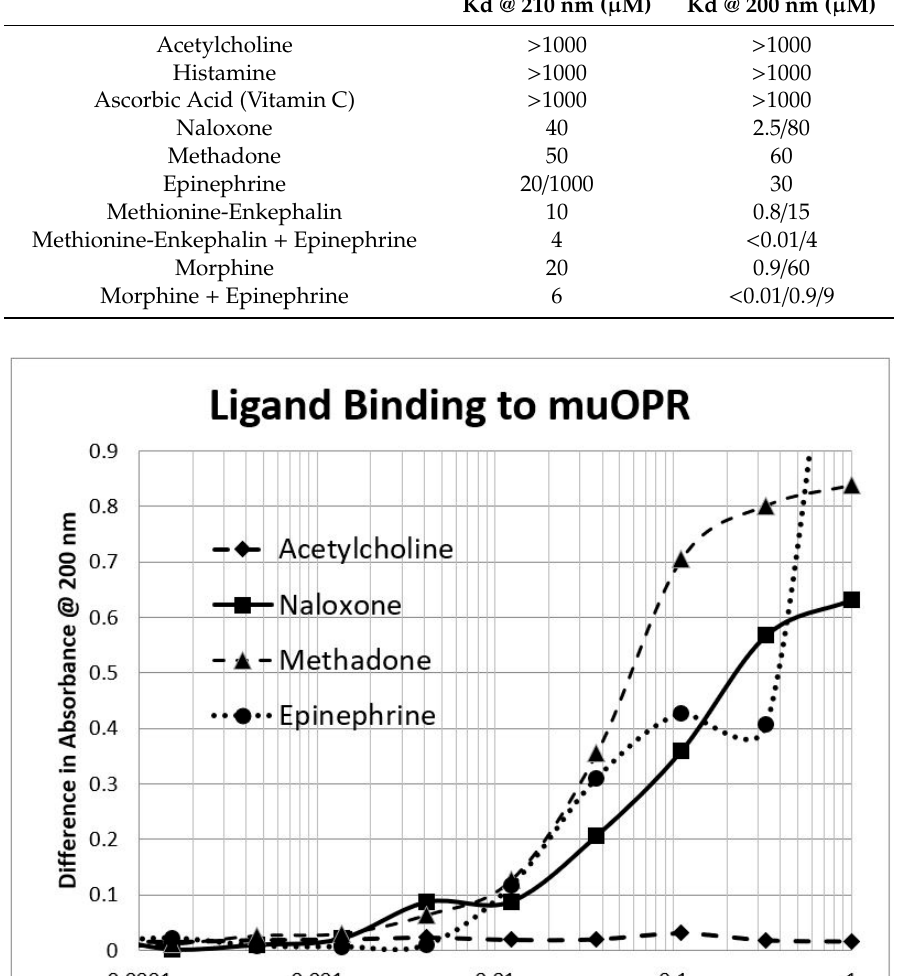
Figure 11. Ligand binding to intact mu opioid receptors (muOPRs). Acetylcholine demonstrated no observable bind while methadone, naloxone, and epinephrine bound at mid-micromolar concentrations. Table 3. Binding constants (micromolar) for various ligands to intact mu opioid receptors (some data from [56]). Some binding curves displayed evidence of high and low affinity binding, indicated in the table by two or more Kd values separated by a slash. The presence of a question mark indicates that one of the curves is very small and possibly not reliable.